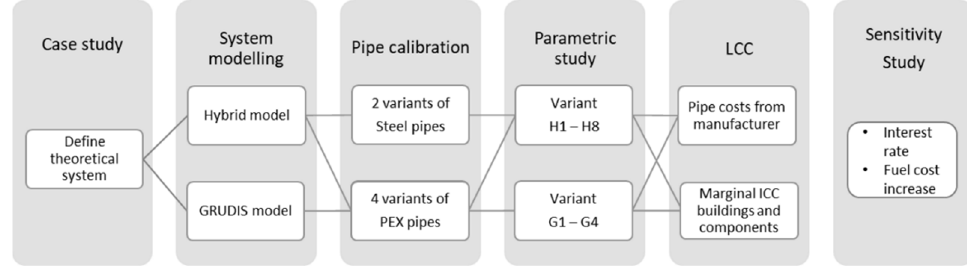
Figure 1. Overall process—flowchart showing how the work in this study was executed.